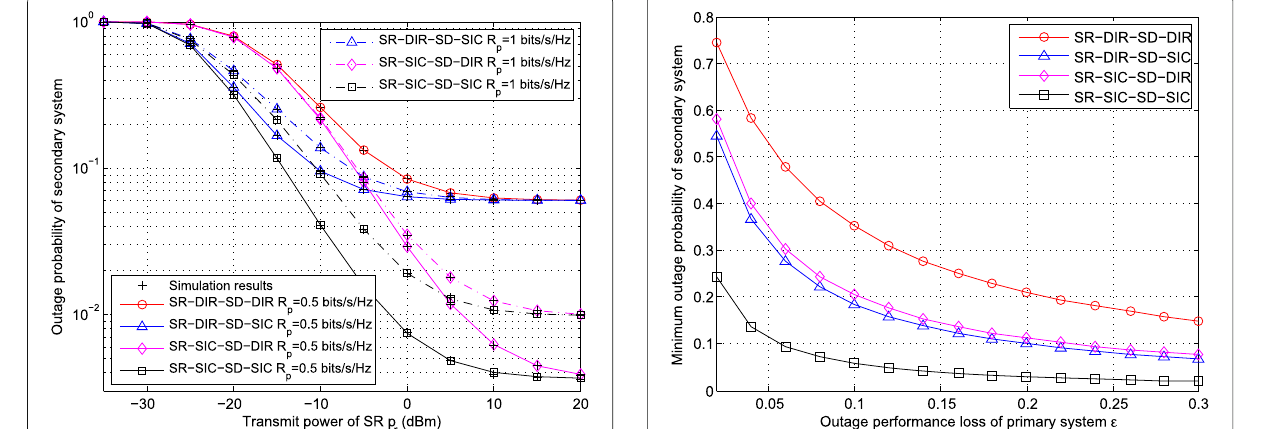
Fig. 8 Outage probability of secondary system vs the transmit power of SR